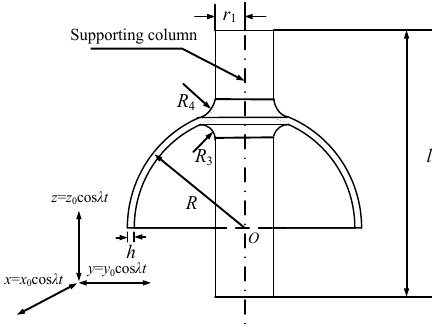
Figure 2. Sectional view of a hemispherical resonator.